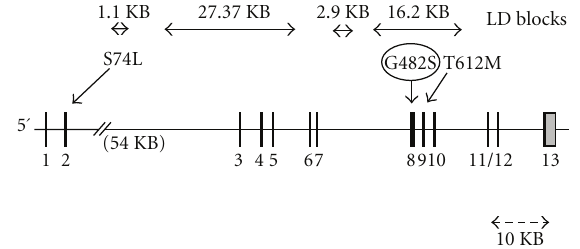
Figure 2: Structure of the PPARGC1A gene showing location of linkage disequilibrium (LD) blocks and sequence